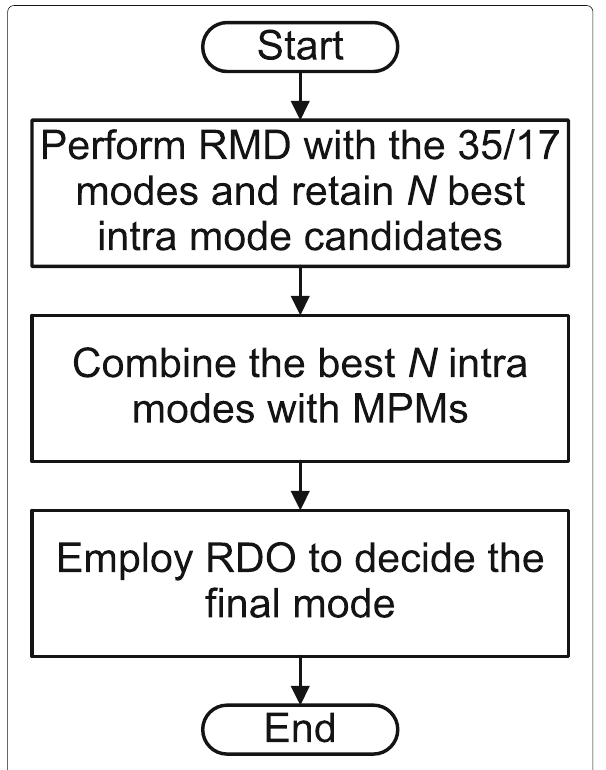
Fig. 3 Intra-coding decision process in